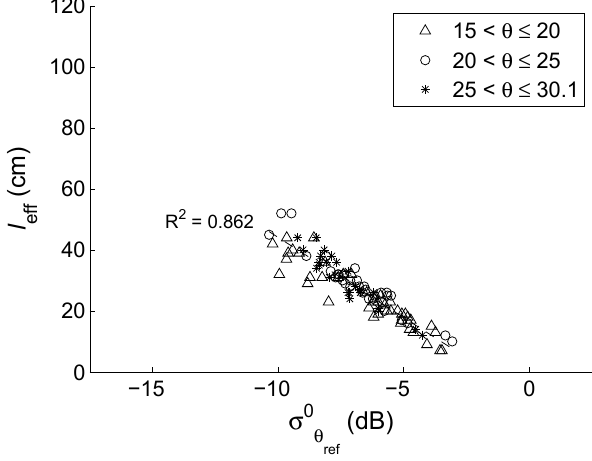
Fig. 8. Dependence of s eff on the normalised backscatter observa- tions ( σ 0 ) for different intervals of incidence angle θ . θ ref Table 2. Regression model parameters and accuracy evaluation.